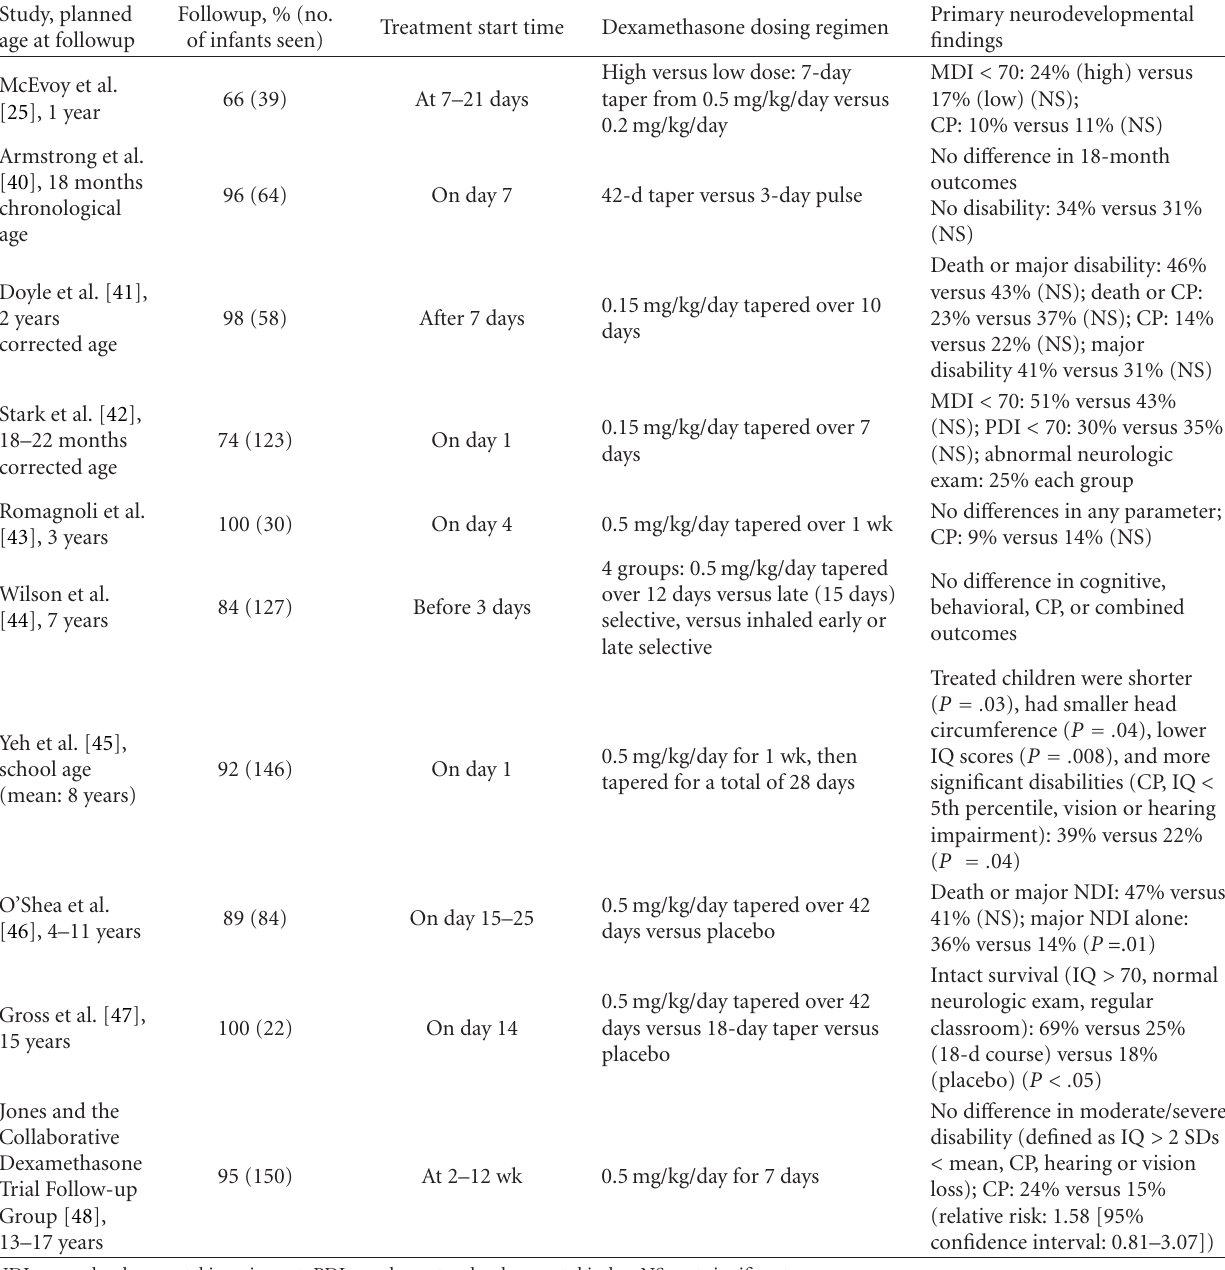
Table 2: Neurodevelopmental follow-up of dexamethasone RCTs reported after